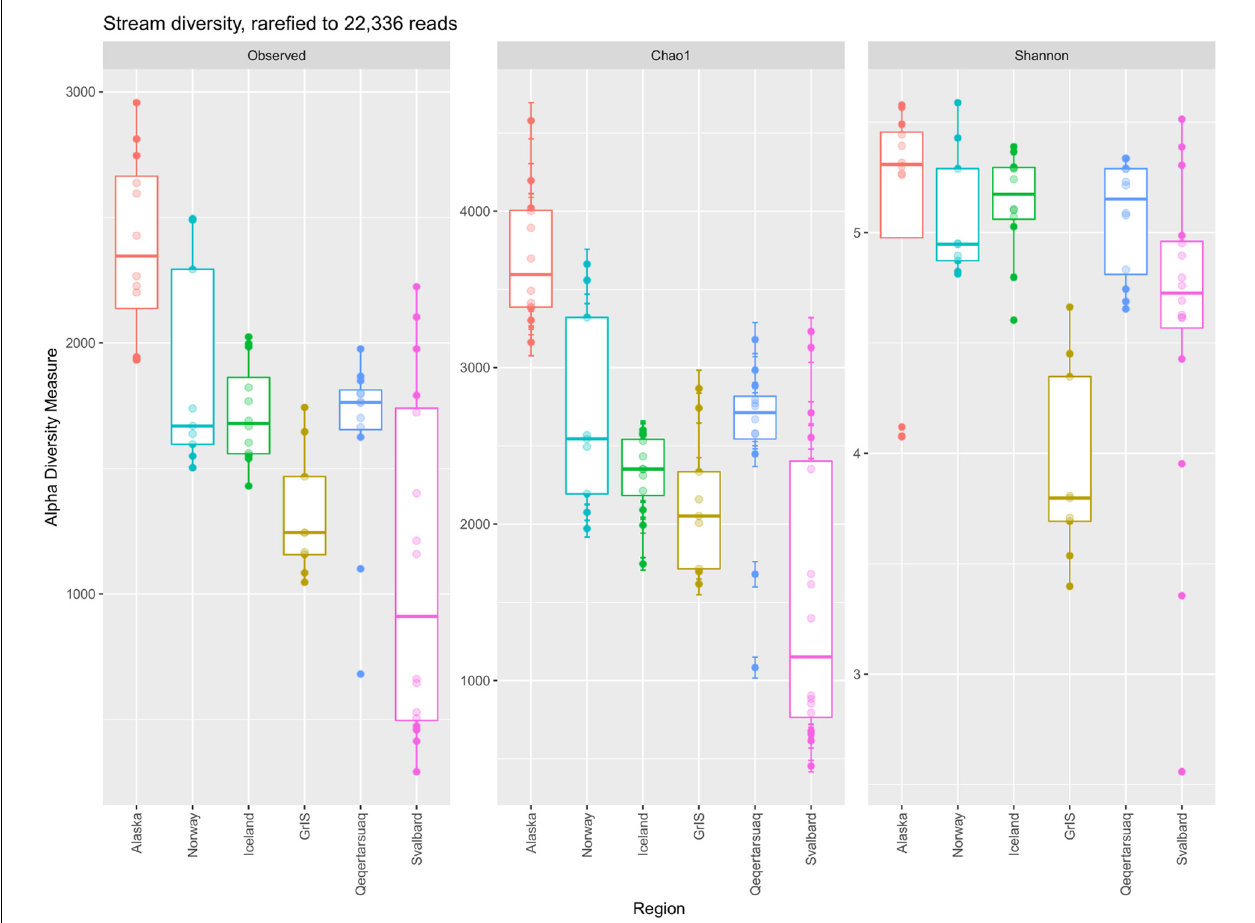
FIGURE 3 | Boxplots comparing the observed number of OTUs, Chao1, and Shannon diversity between major (sub)Arctic regions. The dataset was rarefied to 22,336 reads, and regions ( x -axis) are ordered by increasing